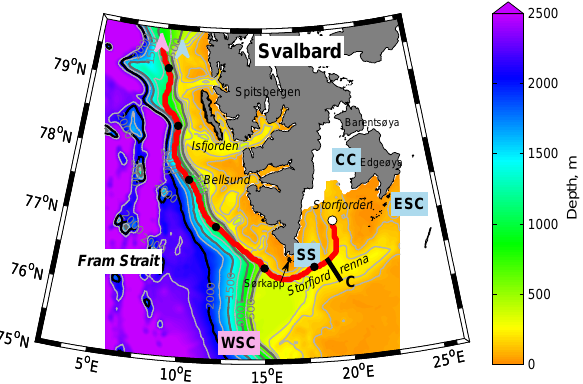
Fig.1. Bathymetryofthemodeldomain(shaded).Faintcontoursaredrawnevery100mforthefirst400m,thenevery250mwithstronger Fig. 1. Bathymetry of the model domain (shaded). Faint contours linesat500,1000,1500and2000m(labelled).Thecappedbathymetryat2500misshownasablackdottedline.Ageneralisedplumepath- way(redline)ismarkedevery100km(filledcircles)downstreamofthesill(opencircle).Schematiclocationsofmaincurrents(takenfrom are drawn every 100m for the first 400m, then every 250m with Saloranta,2001;Skogsethetal.,2005b)areabbreviatedasWSC=WestSpitsbergenCurrent,ESC=EastSpitsbergenCurrent,CC=Cyclonic CoastalCurrent,SS=Sørkappstrømmen.Cross-sectionC(takeninAug2002byFeretal.,2004)isshownasaboldline. stronger lines at 500, 1000, 1500 and 2000m (labelled). The capped bathymetry at 2500m is shown as a black dotted line. A gener- mixingareproportionaltothehorizontaldeformationofthe flow. Such a non-linear scheme is thus a more physically alised plume pathway (red line) is marked every 100km (filled cir- based formulation of horizontal mixing (compared to linear schemes) and has become the preferred method in modern cles) downstream of the sill (open circle). Schematic locations of grid-pointmodels(BeckerandBurkhardt,2007). 175 main currents (taken from Saloranta, 2001; and Skøgseth et al., In NEMO, the Smagorinsky-like small-scale horizontal physics in the conservation equation for tracers – the hori- 2005b) are abbreviated as WSC, West Spitsbergen Current; ESC, zontaldiffusionterm D hor forheat,saltandpassivetracers– iswrittenas(Madec,2008): East Spitsbergen Current; CC, Cyclonic Coastal Current; and SS, Sørkappstrømmen. Cross-section C (taken in August 2002 by Fer et al., 2004) is shown as a bold